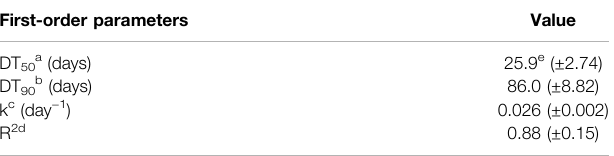
TABLE3| First-order fi elddissipationparametersofglyphosateinacitrusorchard (Location: Immokalee, FL). First-order parameters